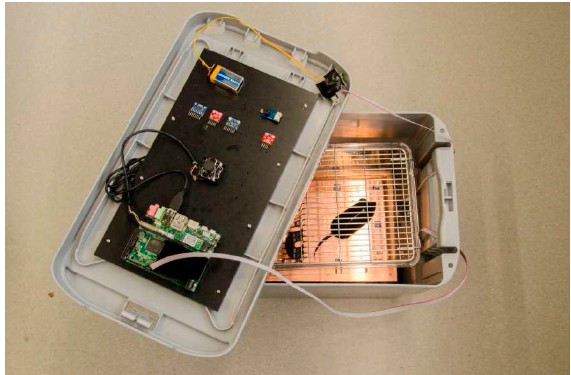
Figure 6. Functional transport box with integrated monitoring system. (Top) Backside of the box cover with all hardware components installed—CPU board and environmental sensors. (Bottom) Matrix of EPIC sensors to capture mouse physiological signals.